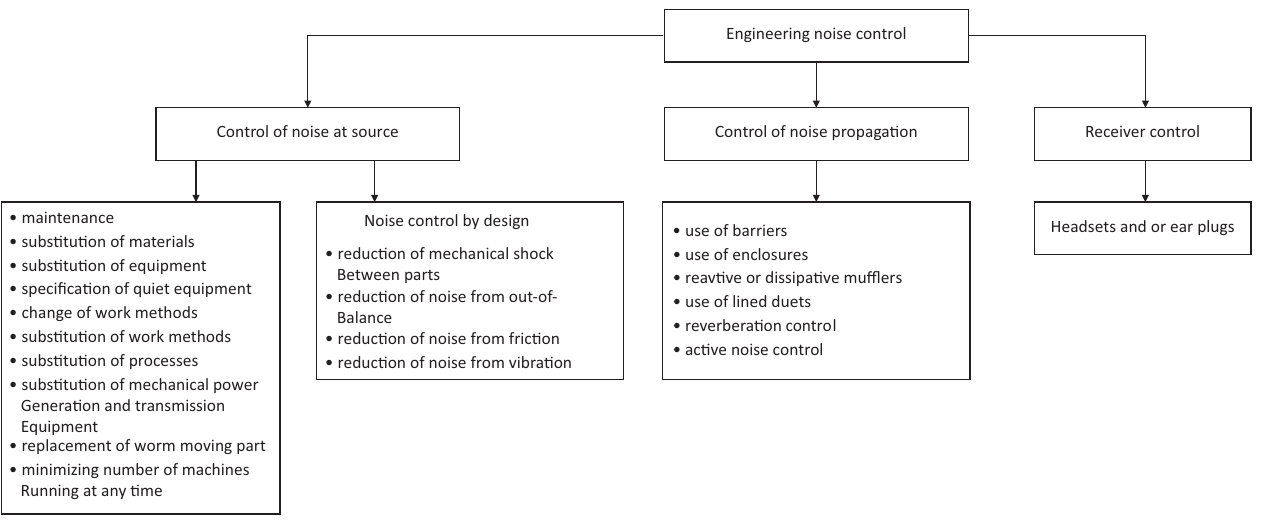
FIGURE 2: An overview of engineering noise